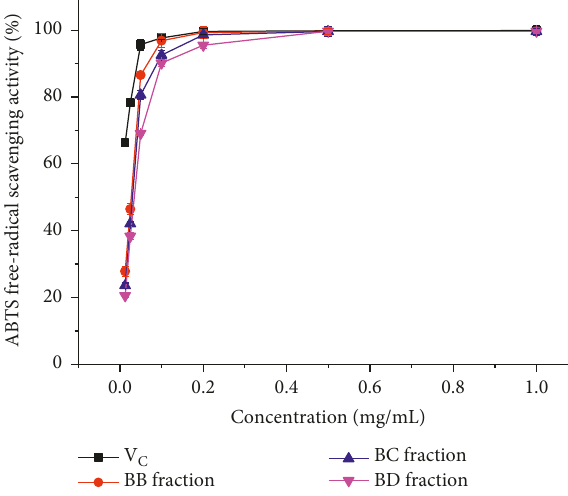
Figure 6: ABTS-scavenging activity of V fractions.